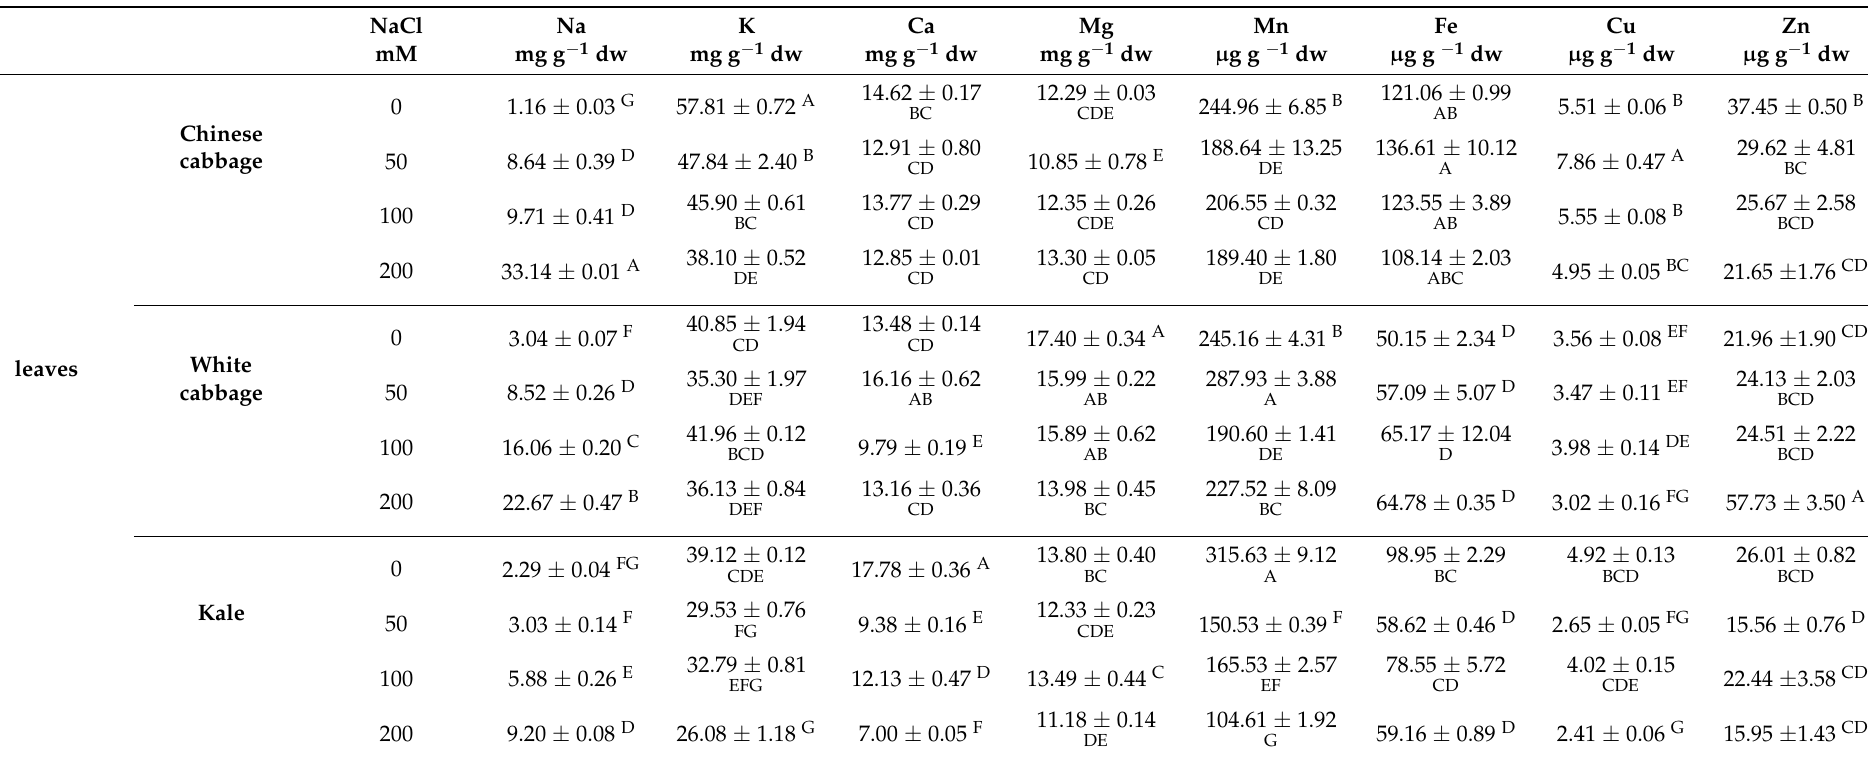
Table 3. Macro- and micro-elements in Brassica leafy vegetables leaves and root upon salinity treatments (0–200 mM NaCl). Data labeled with different letters differed significantly at p < 0.05 for each particular element among the three species, separately for leaves (small letters) and roots (capital